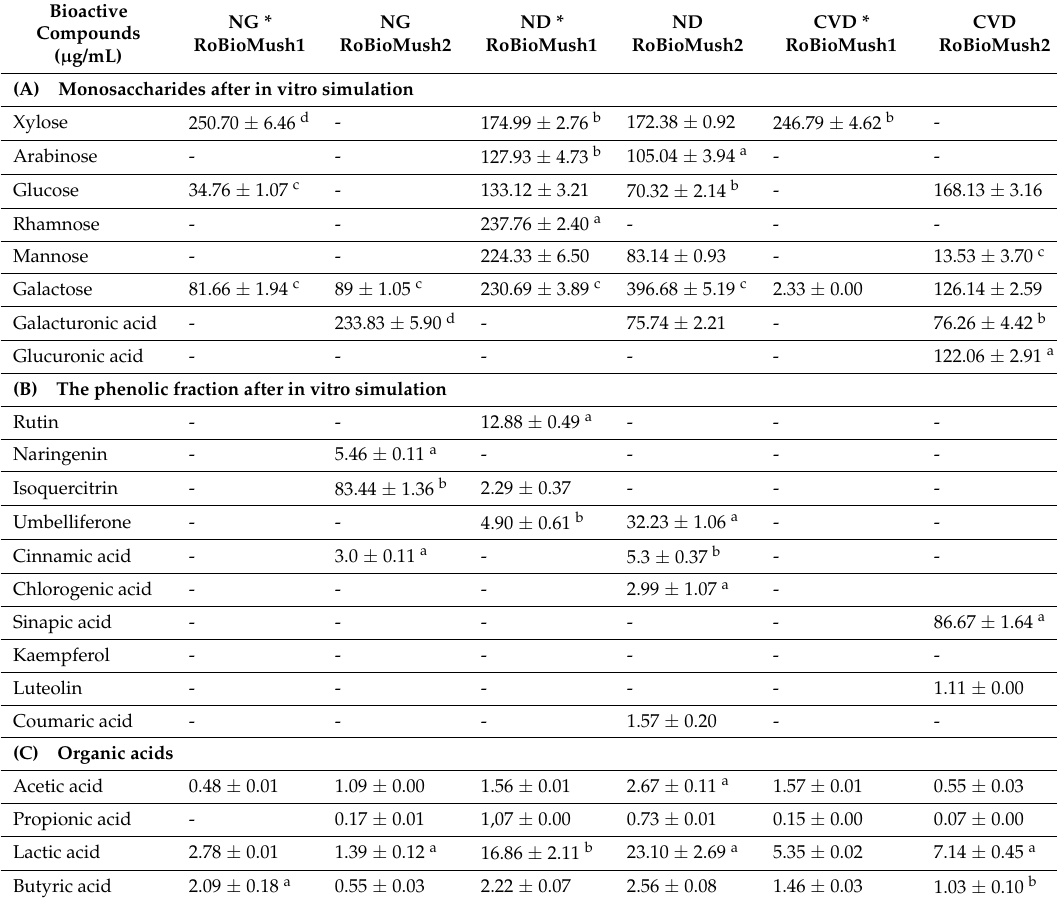
Table 2. The average amount of monosaccharides ( µ g/mL), the phenolic fraction ( µ g/mL) and organic acids (mg/mL) following simulation in the three-stage culture